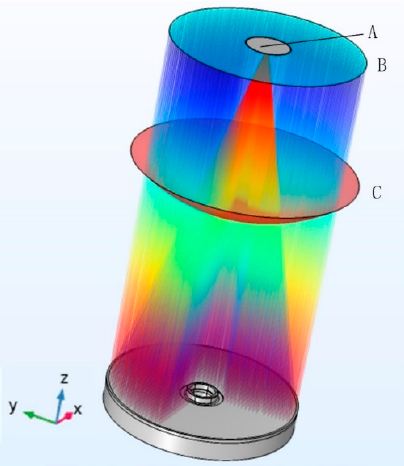
Figure 8. Optical path diagram of the primary mirror. A: The ideal image plane; B: The outgoing surface of light; C: The Gaussian reference sphere.